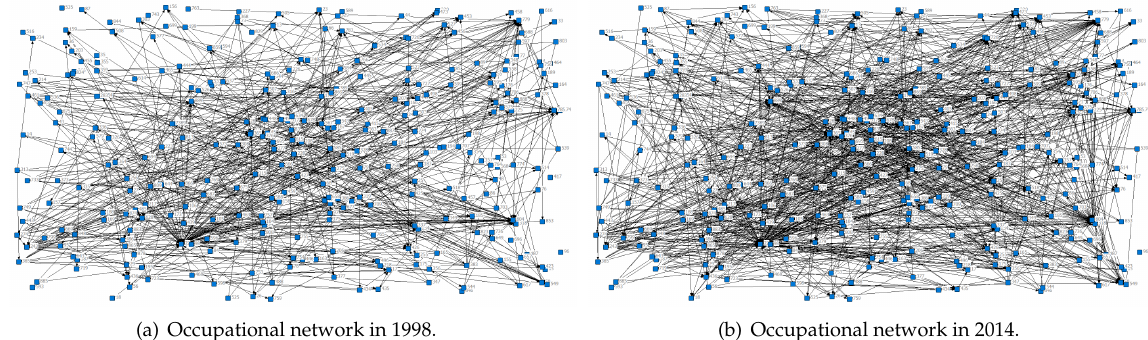
Figure 1: Occupational networks for all working men in 1998 and 2014 restricting ties to occupational transi- tions with monthly probabilities greater than